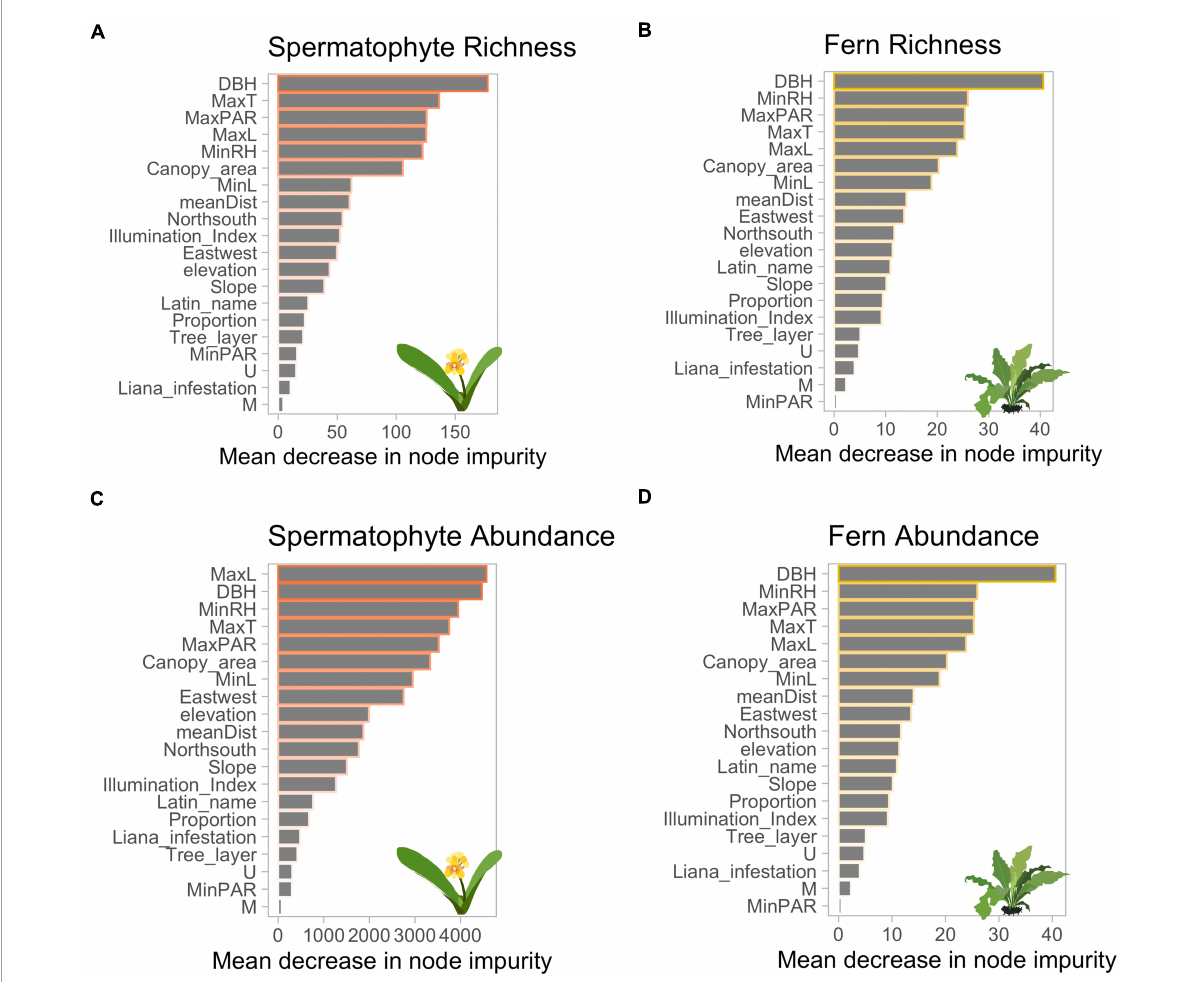
FIGURE3 Mean decrease in node impurity of the factors accounting for epiphytic spermatophyte (A) and epiphytic fern (B) species richness and for epiphytic spermatophyte (C) and epiphytic fern (D) abundance per tree. See Table 1 for